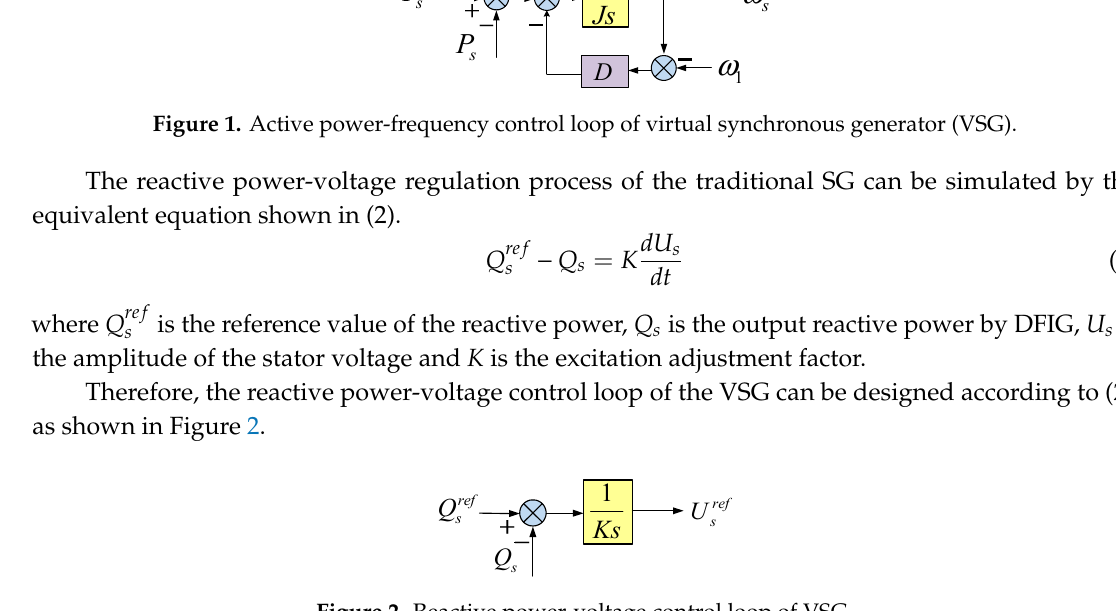
Figure 2. Reactive power-voltage control loop of VSG.